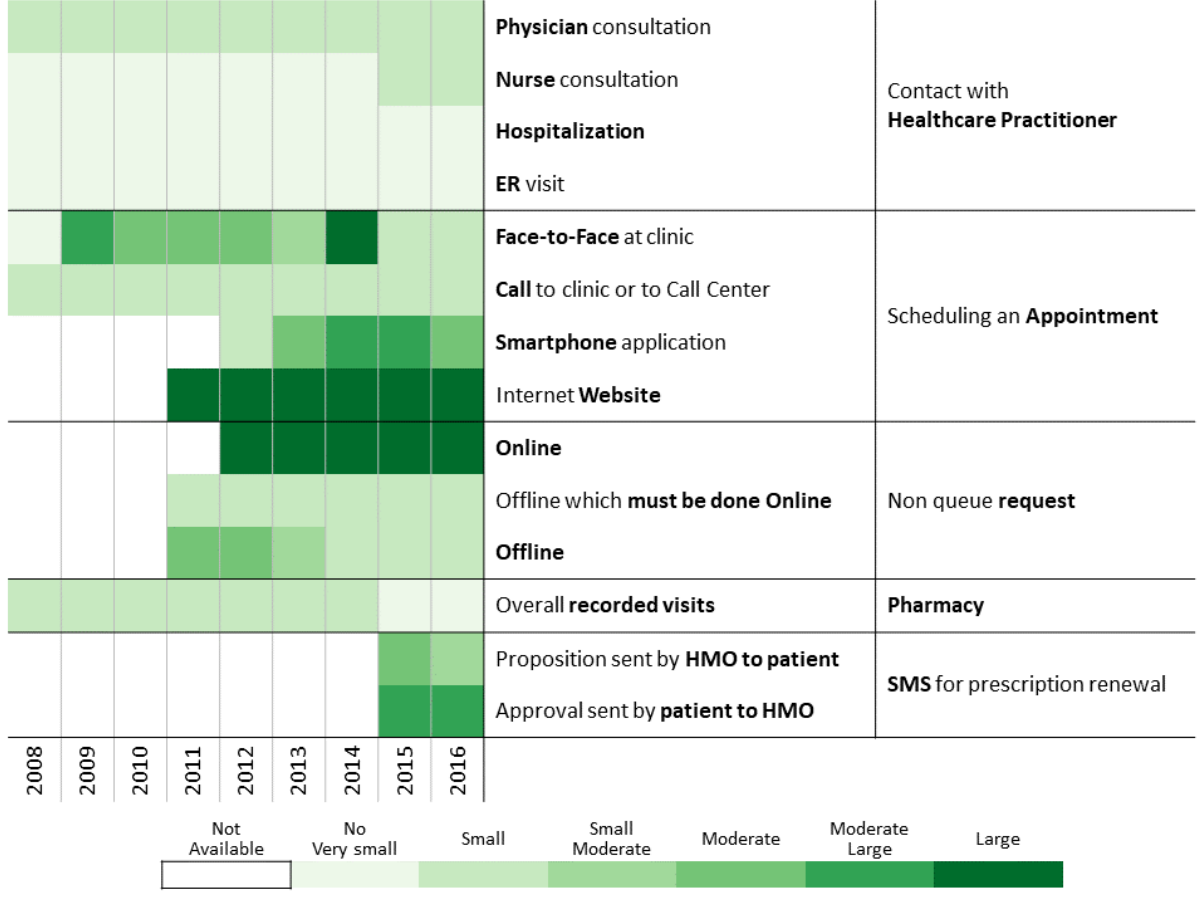
Figure 13. Communication pattern changes for patients having a high volume of electronic contacts over the health management organization